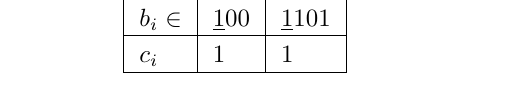
Table 5: The positions of active bits in c for b ∈ F ‘